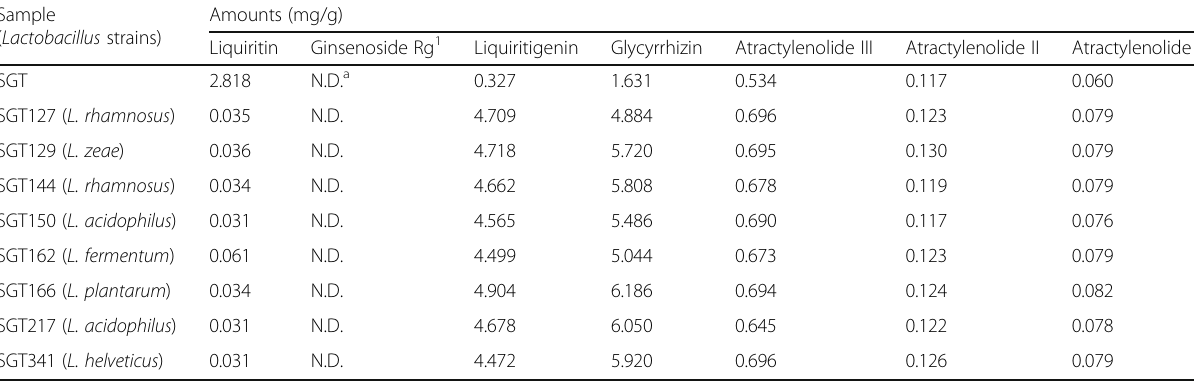
Table 2 Amounts of the seven compounds in SGT and fermented SGTs